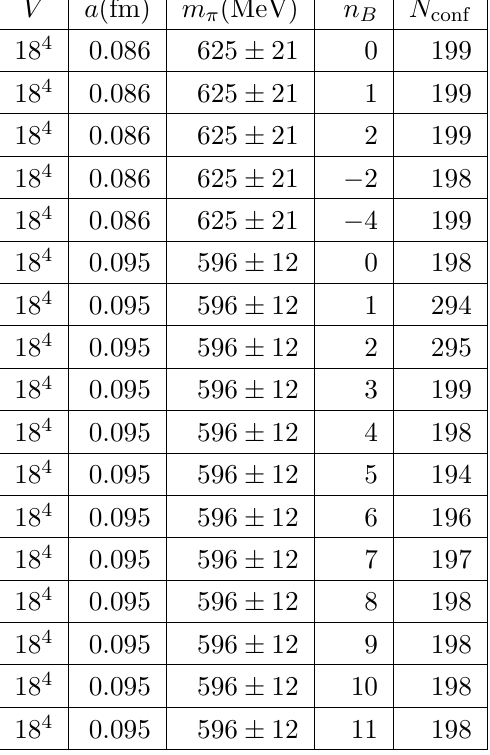
The lattice parameters such as the volume, the lattice spacing, the pion mass and the number of the lattice gauge con(cid:12)gurations used for the calculations for the each value of the magnetic (cid:12)eld. The value of the magnetic can be calculated according to equation (2.13), the negative value of n B corresponds to the negative projection of the magnetic (cid:12)eld on the ’z’ axis. V a